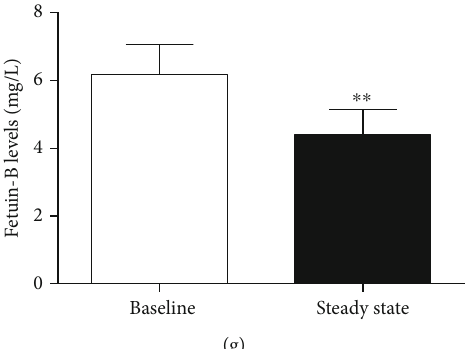
Figure 1: Circulating Fetuin-B concentrations in interventional studies. (a) Circulating Fetuin-B concentrations in healthy and PCOS women during an OGTT. (b) Circulating TNF α levels in PCOS and healthy women during an OGTT. (c) Time course of circulating Fetuin-B changes in healthy and PCOS women during the EHC. (d) Time course of circulating TNF α changes in healthy and PCOS women during the EHC. (e) Glucose infusion rates (GIR) in control women at pre- and postlipid infusion. (f) Time course of circulating Fetuin-B changes in control women during lipid infusion combined with EHC. (g) Circulating Fetuin-B levels at pre- and postlipid infusion. Data are means ± SEM . ∗ p < 0 : 05 or ∗∗ p < 0 : 01 vs. control or baseline; ▼ p < 0 : 05 or ▼▼ p < 0 : 01 vs.